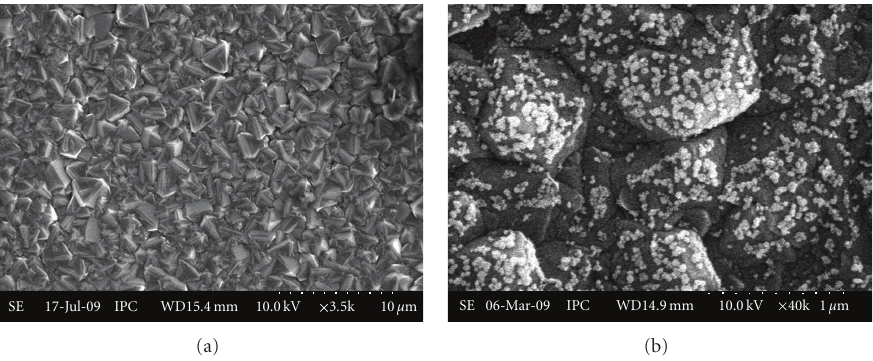
Figure 9: SEM images obtained from the BDD (a) and OT-Au-BDD (b)